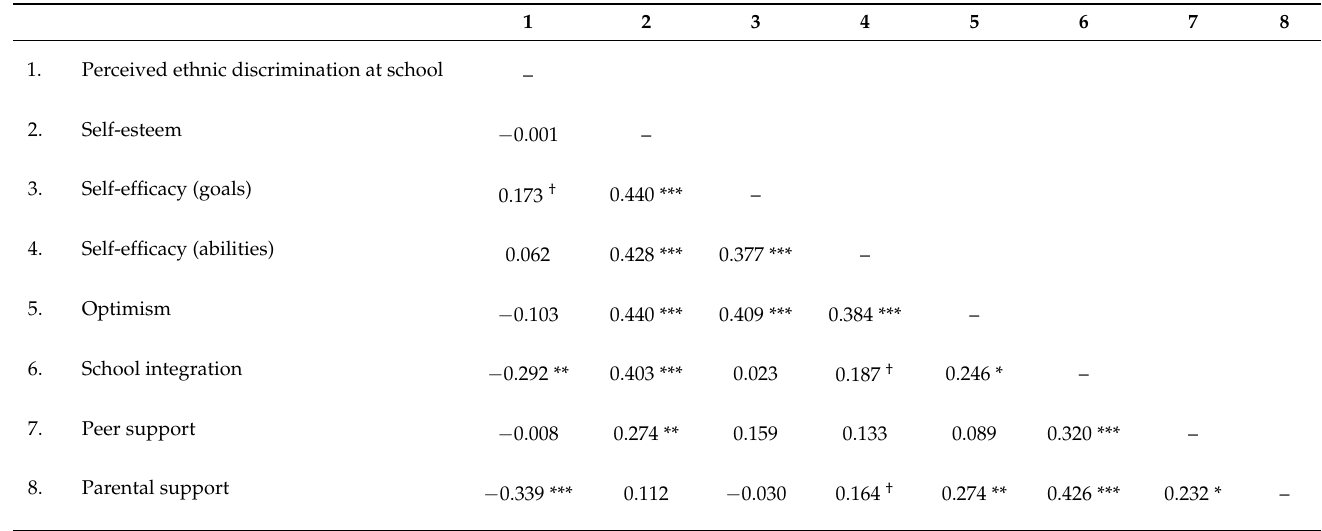
Table 2. Correlations between main study variables ( N = 104).